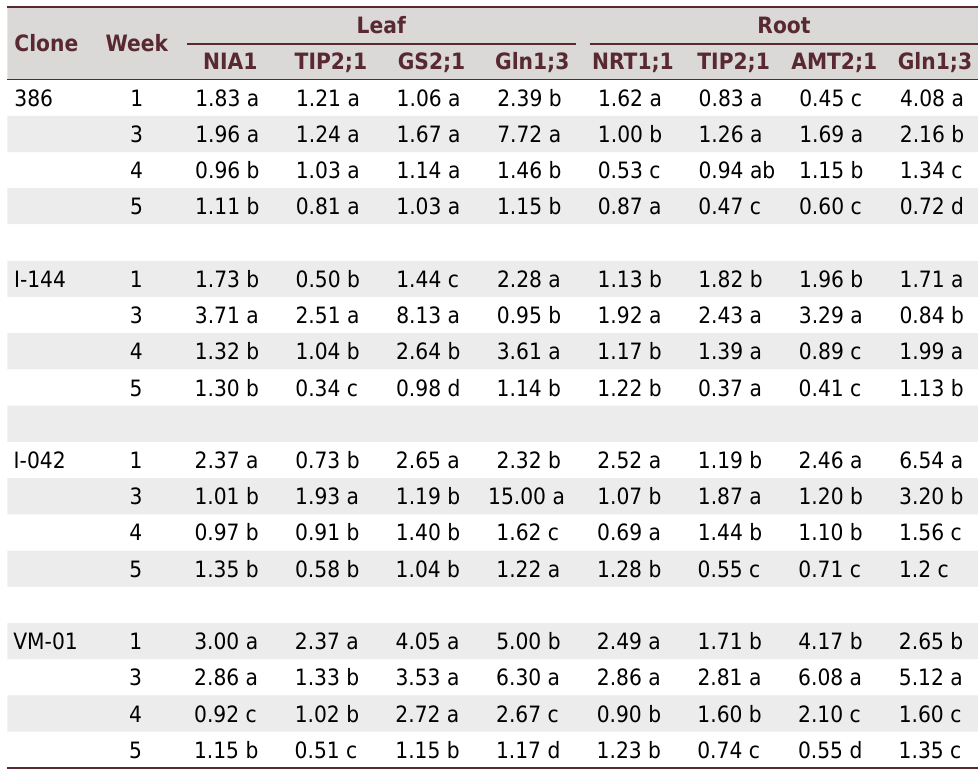
Table 7. Relative gene expression related to nitrogen metabolism in roots and leaves of Eucalyptus clones (386, I-144, I-042 and VM-01) in response to nitrogen omission (weeks 1 and 3) and nitrogen resupply (weeks 4 and